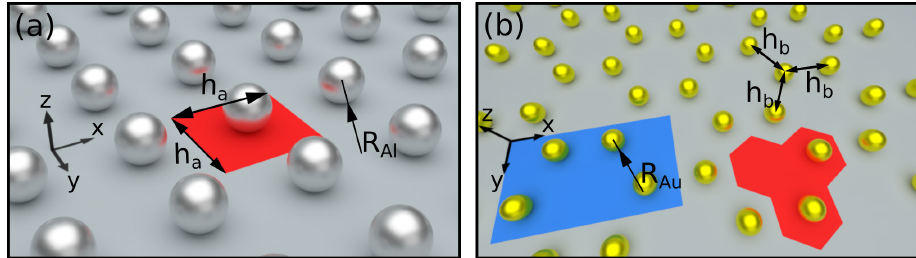
Figure 1. Schematic representation of ( a ) square array of Al nanoparticles (NPs) with h a = 280 nm, R Al = 60 nm, medium refractive index n h = 1.5 and ( b ) honeycomb array of Au NPs with h b = 600 nm, R Au = 120 nm, n h = 1.45. The red rectangle in ( a ) and red hexagon in ( b ) denote primitive cells for corresponding structures. The blue rectangle in ( b ) highlights the simulation domain with periodic boundary conditions for finite-difference time-domain (FDTD) calculations. Notice that the simulation domain and primitive cell coincide for the square array in ( a ). The unit cell for the honeycomb array consist of two NPs but in case of an infinite array simulated using the FDTD method, four NP comprising unit cells were used to reproduce infinity with orthogonal translation vectors ( b